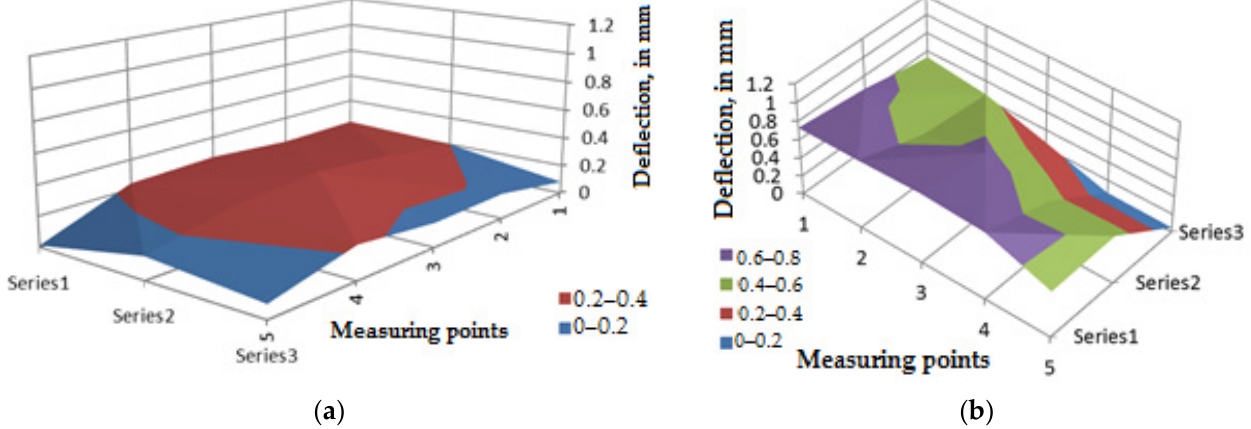
Figure 8. Deflection values and warpage of blockboard with HDF faces tested in the kitchen: ( a ) at the beginning of the experiment; ( b ) after three months of exposure in the kitchen.